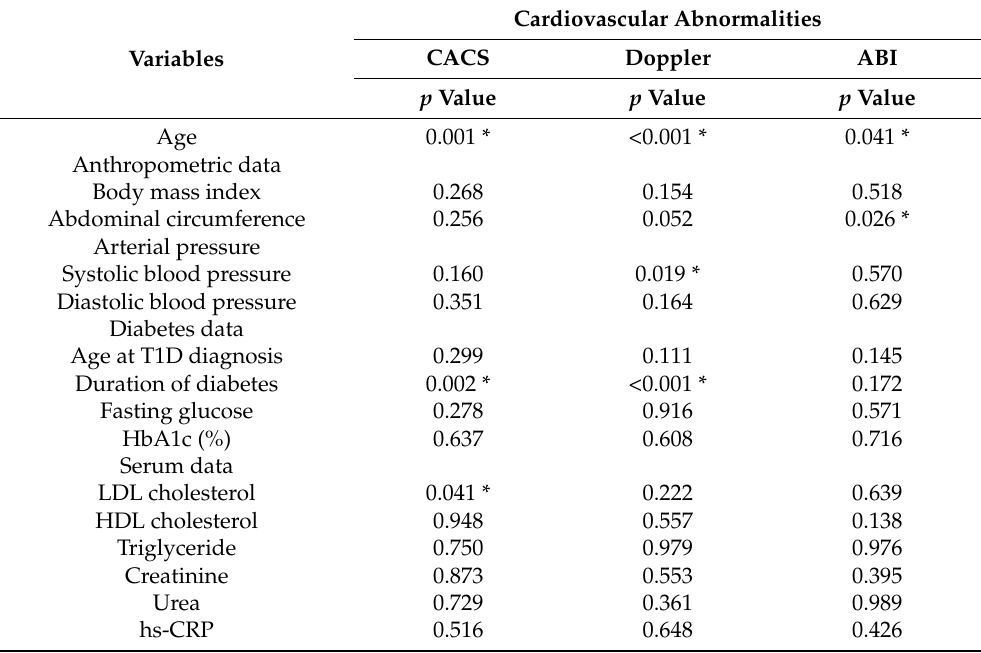
Table 4. Results of comparison tests ( p values) of the clinical and serum data in type 1 diabetes patients according to early markers of cardiovascular